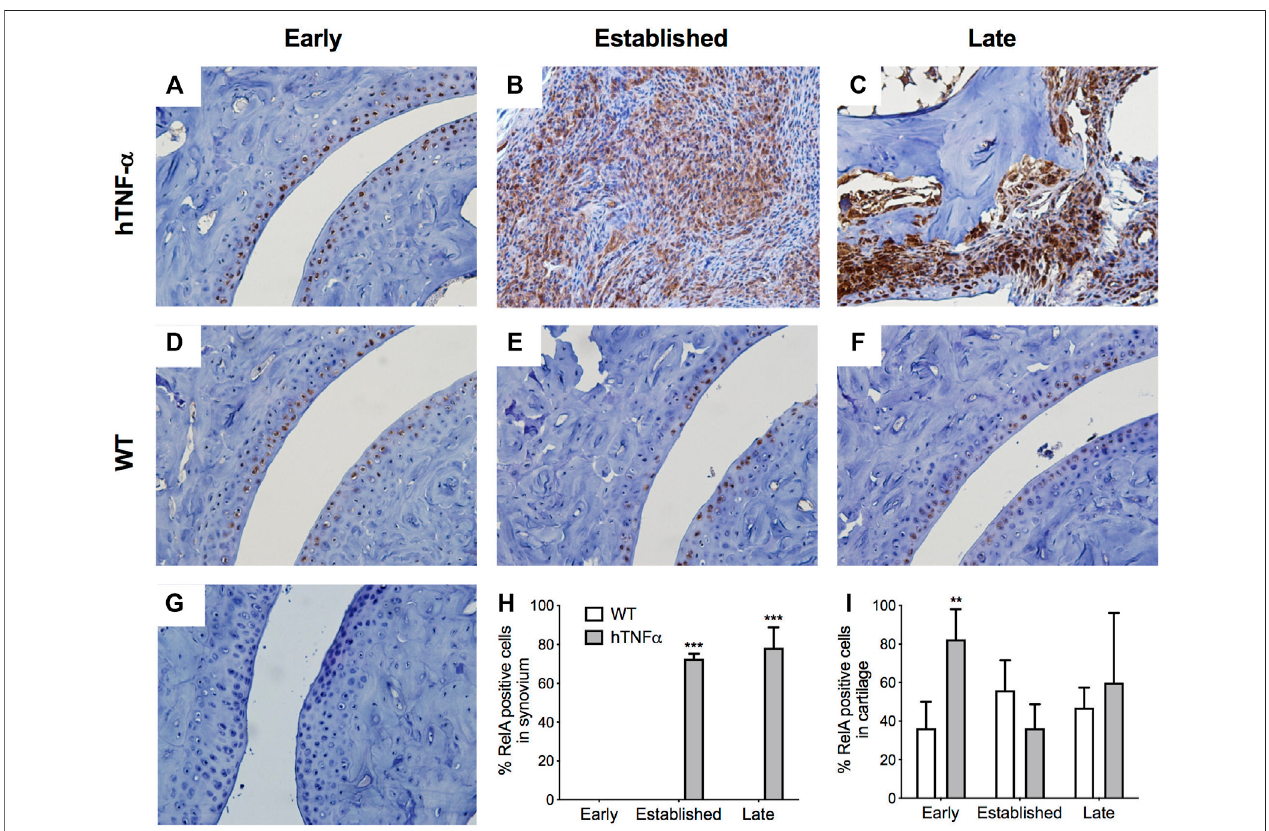
FIGURE3| LocalizationofRelAincartilageandsynovium.RelAwasdetectedinpawsofwild-typeandhTNF- α miceatearly (A,D) ,established (B,E) ,andlate (C,F) stages of disease by immunohistochemistry. Isotype control was applied to a transgenic section from the late stage of disease (G) . Representative images at 400× magni fi cation are shown. Scoring of RelA positive cells in synovium (H) and cartilage (I) . Unpaired t -test, ** p < 0.005, *** p <